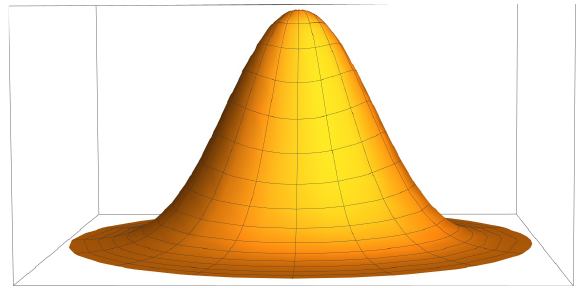
1 it t 2 + it 3 t 2 − − − (cid:31)